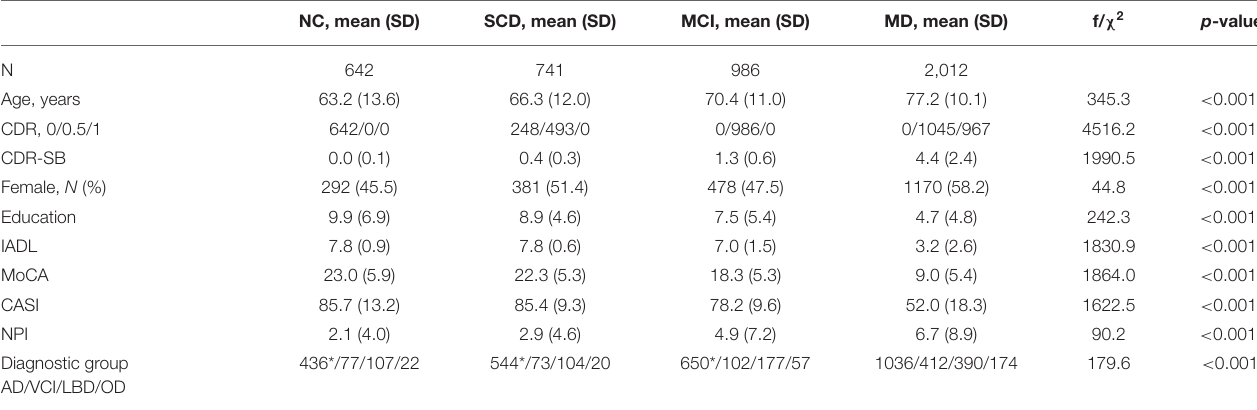
TABLE 2 | Comparison of the demographic data among participants with normal cognition, subjective cognitive decline, mild cognitive impairment, and mild dementia in the test phase. NC, mean (SD) SCD, mean (SD) MCI, mean (SD) MD, mean (SD) f/ χ 2